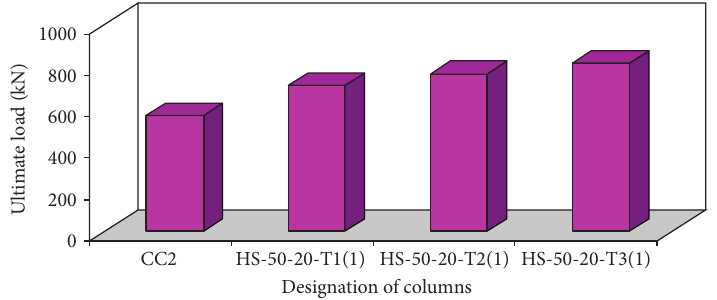
Figure 18: Ultimate load for columns